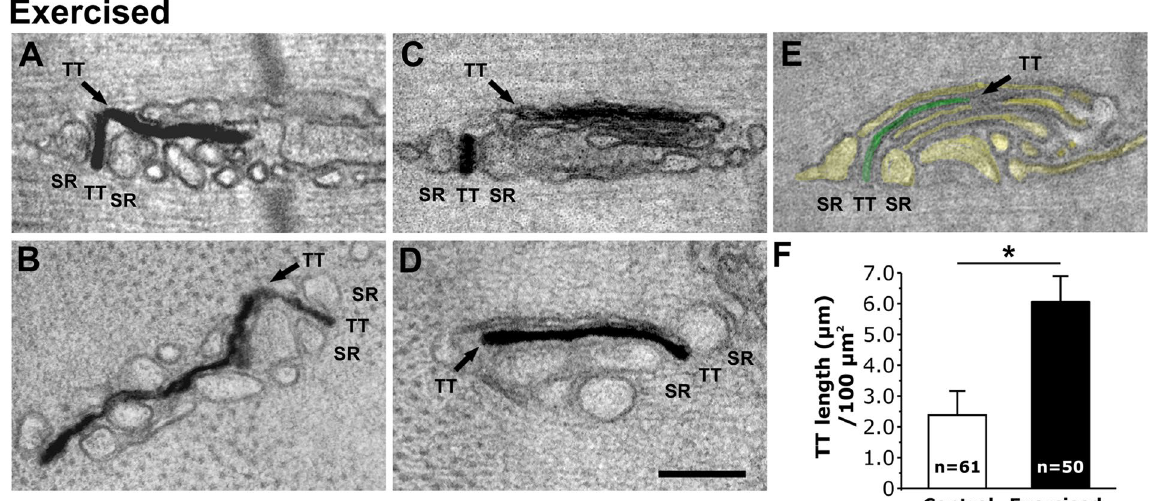
Figure 2. Following exercise, TT extensions at the I band are more frequent and become part of stacks of flat- cisternae. ( A – D ) Representative EM images ( A and C , longitudinal; B and D , cross) showing TTs (stained black with ferrocyanide-precipitate) extending from the triad into the I band to make contact with SR vesicles ( A and B ) and stacks of flat-cisternae ( C and D ). ( E ) TT and SR (green and yellow, respectively) extending from a triad to form a lateral stack of flat-cisternae. ( F ) Quantitative analysis of the TT network extension at the I band measured in cross sections (see also Fig. S3C–F). Sample size: control, 3 mice; exercised, 3 mice . Data are shown as mean ± SEM; * p < 0.01. Numbers in bars (n) indicate the number of fibers analyzed. Scale bar: 0.1 μ